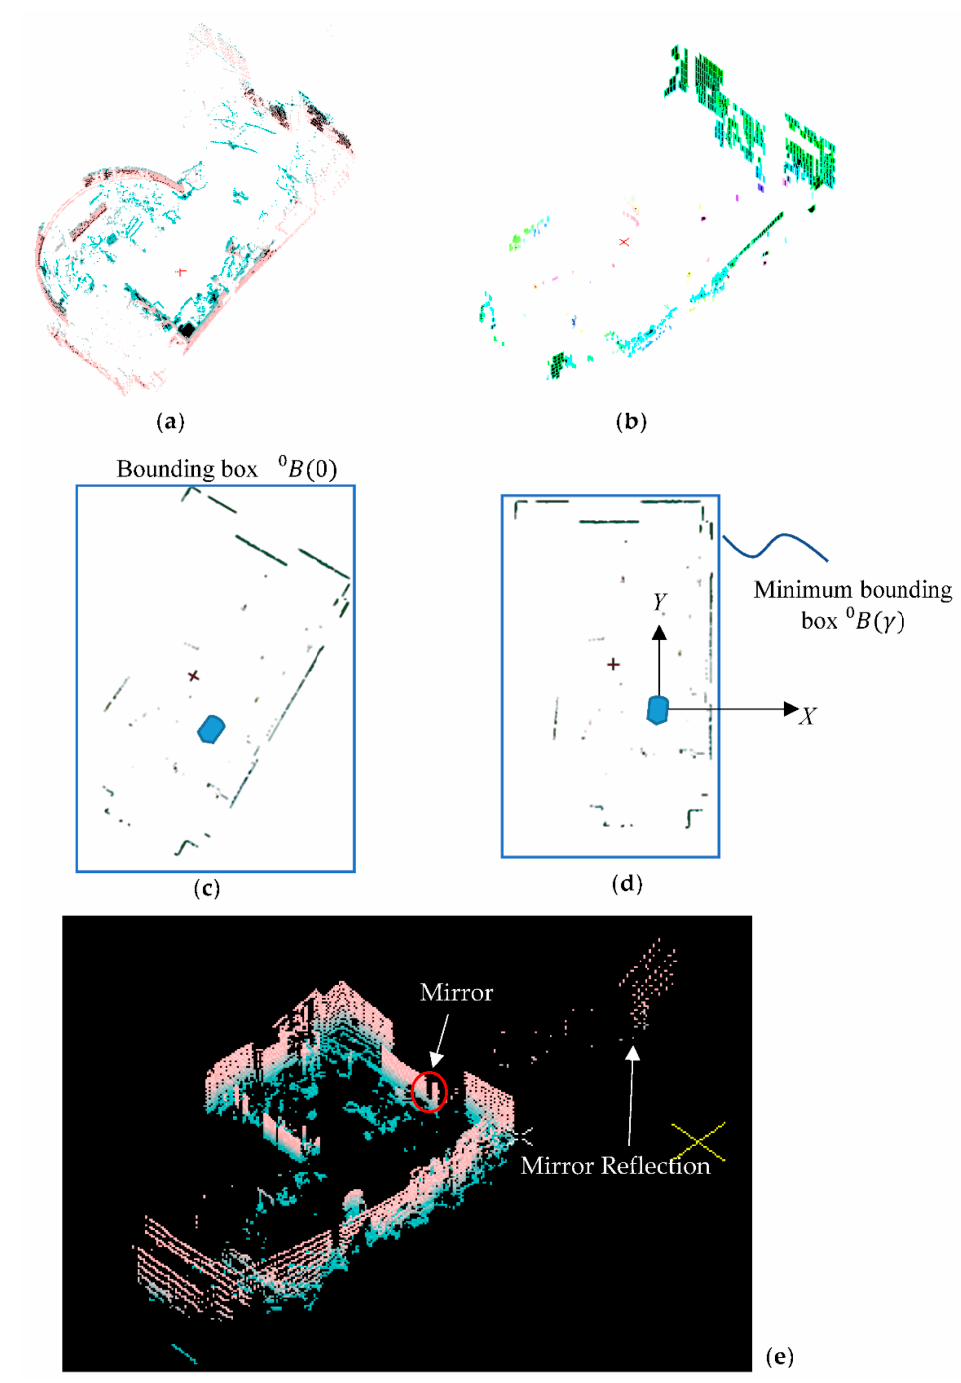
Figure 4. Initial axis finding procedure: ( a ) point cloud, ( b ) mesh filtering, ( c ) XY projection, ( d ) mini- mum area bounding box rotation, ( e ) the aliasing data from the